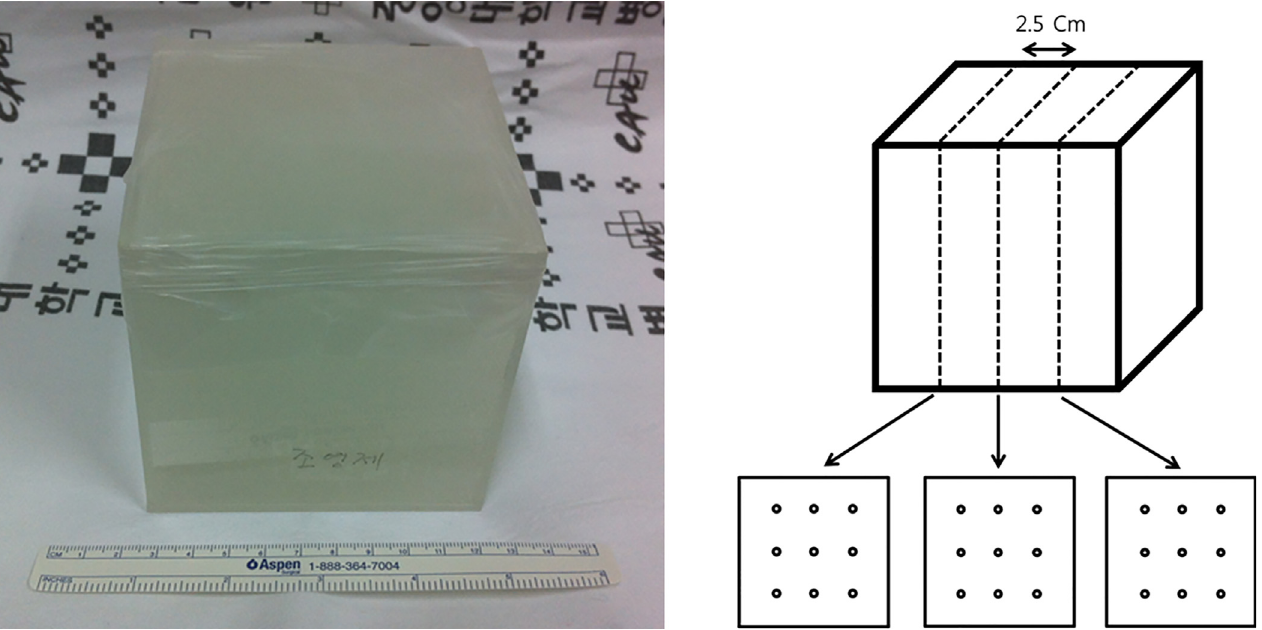
Fig 1. Picture of a container with the PACM and dye mixture (left panel). The containers with the mixture were scanned at a distance of 2.5 ⅹ 10 − 2 m. A total of 27 circles (nine circles on each of three sections) with 1.0 ⅹ 10 − 2 m diameter were drawn on each scanned image (right panel). Hounsfield units were recorded in each